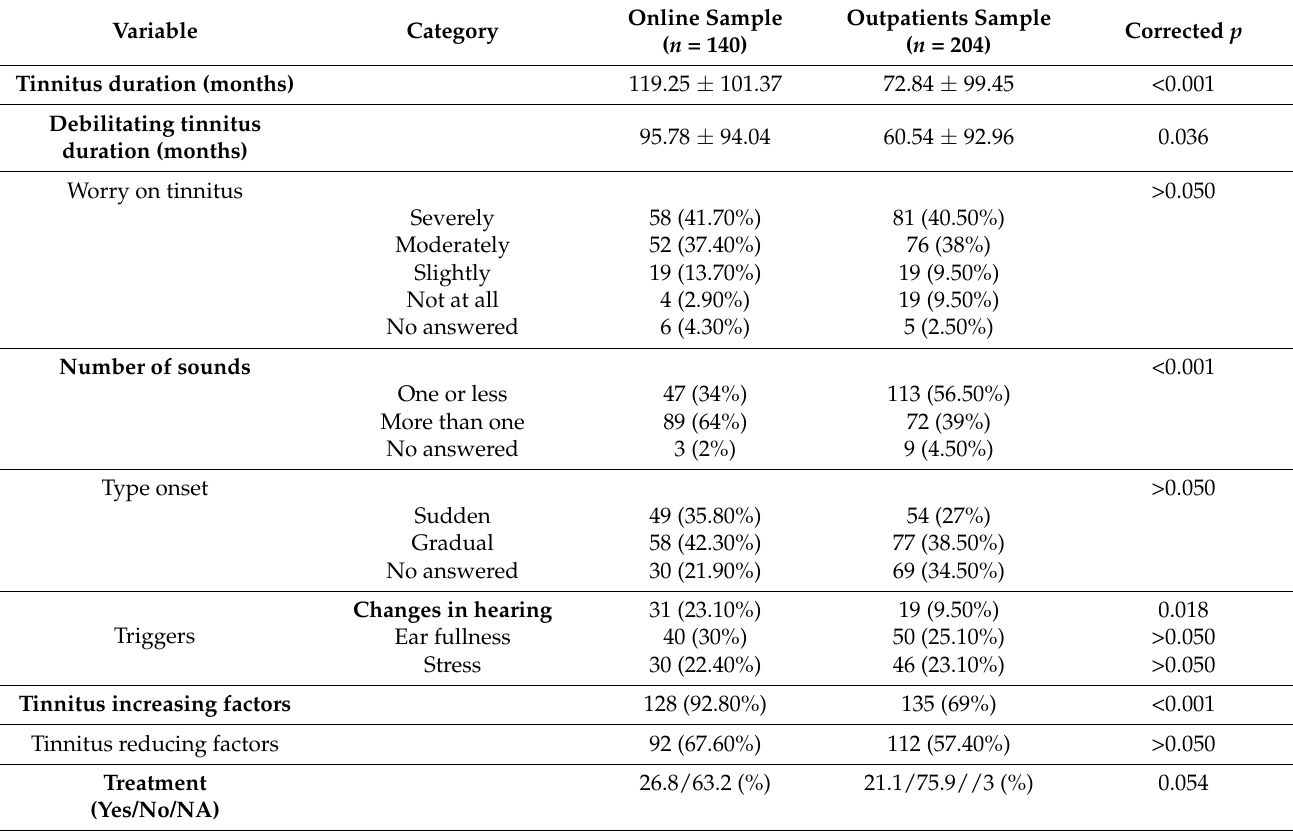
Table 4. Tinnitus characteristics in hospital outpatients and online survey participants after adjusting for sex and age ( n =